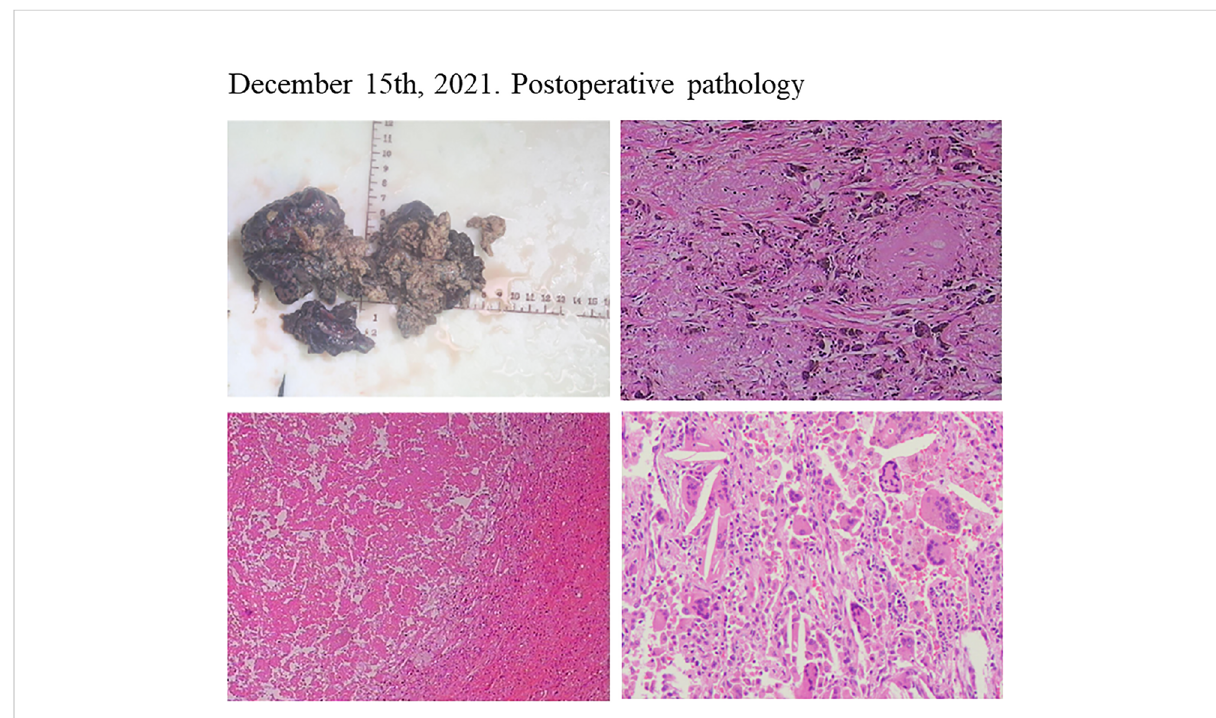
FIGURE 3 Postoperative pathology of the patient after neoadjuvant chemotherapy plus EGFR-TKI showed pathological complete response.